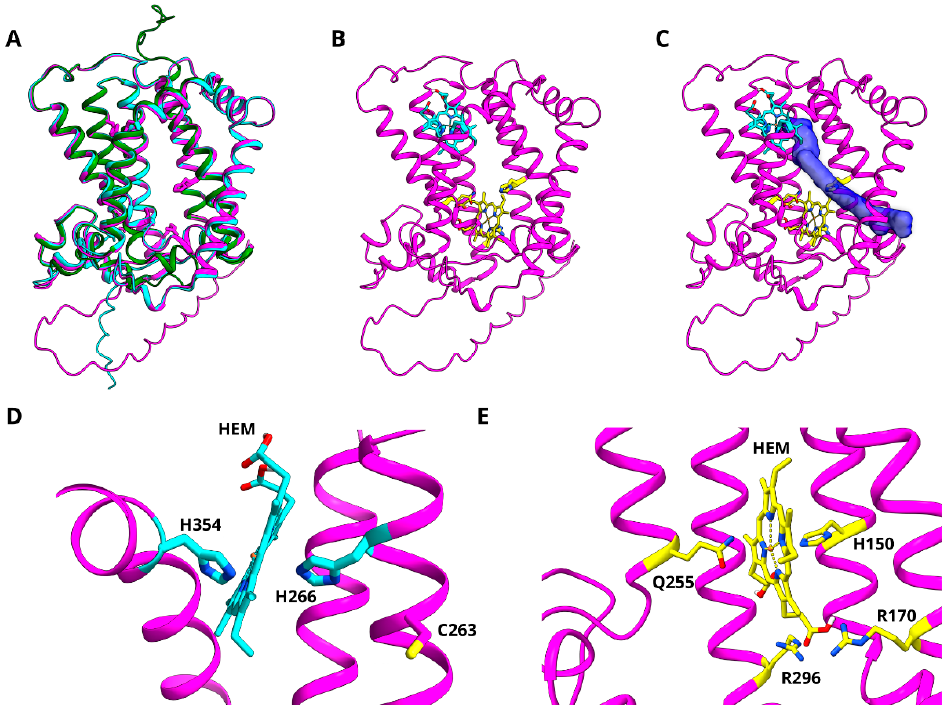
Figure 6. AlphaFold models of Z-ISO. ( A ) Backbone structures of the Synechocystis (green), Arabidopsis (cyan), and maize (magenta) Z-ISO enzymes. ( B ) Positions of the two putative heme (HEM) binding sites in the maize enzyme, with H266 (cyan) and H150 (yellow) acting as heme ligands. ( C ) Density for the lowest-energy mode identified for 9,15,9’-tri- cis - ζ -carotene (purple) binding to maize Z-ISO. ( D – E ) Expanded views of the putative H266 (panel ( D )) and H150 (panel ( E )) binding sites. Two histidine residues, H150 and H266, and a cysteine, C263, have previously been implicated in heme binding/Z-ISO activity in work with the maize enzyme and these residues are conserved in Z-ISO homologs (Figures 2 and S3). Mutagenesis studies showed that H150 and H266 are the only histidine residues required for function in maize Z-ISO [5] and we found the equivalent H29 and H145 residues are important for activity in Slr1599 (Figure 5). Based on homology modelling with maize Z-ISO, Beltràn et al pro- posed that H150 acts as the proximal ligand to the heme cofactor and H266 and C263 act